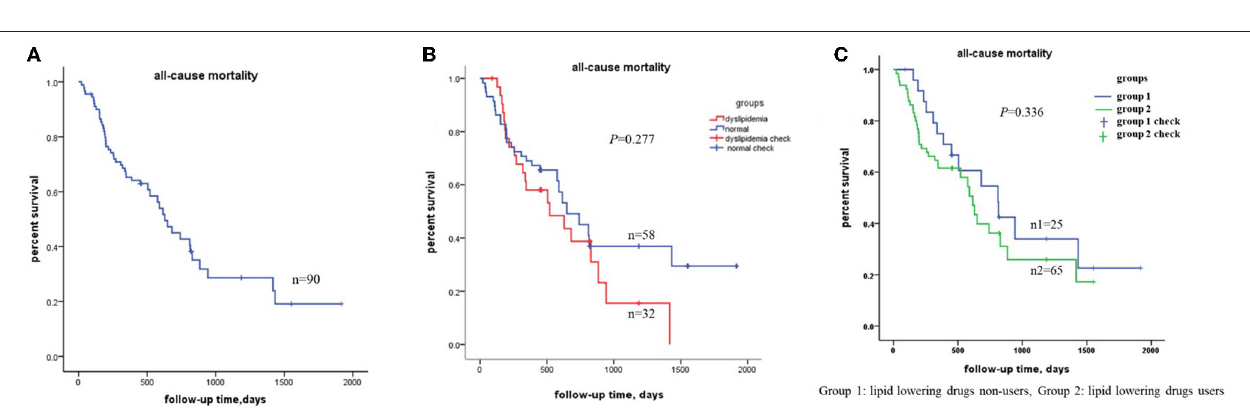
FIGURE 3 | Kaplan–Meier survival curves estimation in the 90 centenarians from recent 5 years (from 2016 to 2021). (A) The total all-cause mortality in the 90 centenarians; (B) the total all-cause mortality between the dyslipidemia group and normal group; (C) the all-cause mortality stratified by the lipid-lowering therapy. Group 1 was for lipid lowering drugs non-users, Group 2 was for lipid lowering drugs users. Both P > 0.05, which indicated the same results as the whole centenarians.